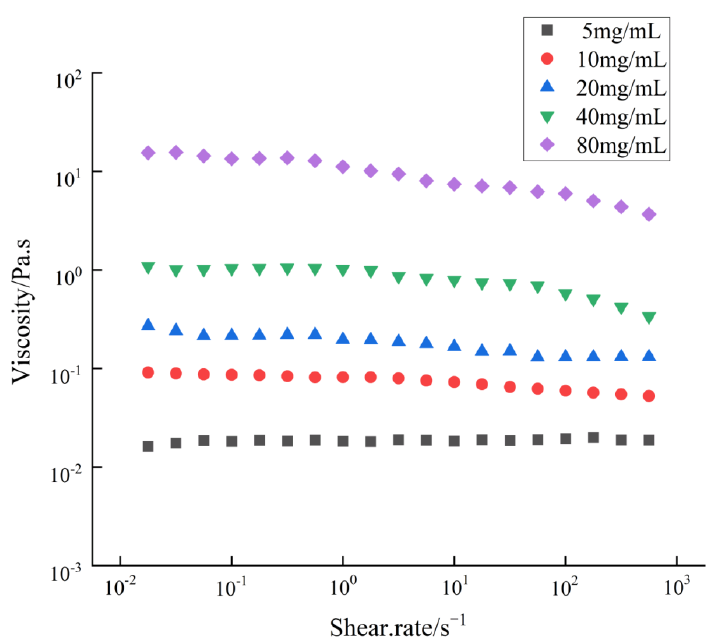
Figure 1. Variation of apparent viscosity of different concentration SAFP with shear rate.